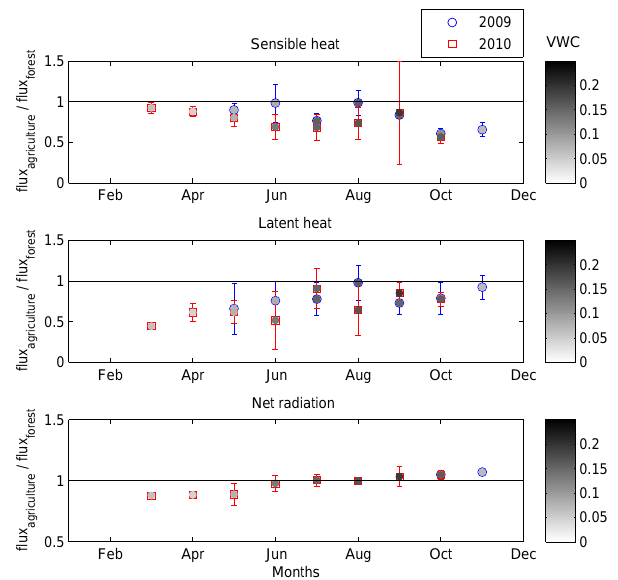
Figure 7. Examination of ratio of the daily fluxes by month and year. The ratios between flux measurements over the field and sa- vanna forest are shown according to the month ( x axis) and year (in color: blue indicates 2009 and red indicates 2010). The soil mois- ture value is shown with shading. Error bars show the standard de- viation around the average of daily ratios. Points below the 1 line indicate when the savanna-forest flux is higher than the agricultural field flux. It is important to note that the field was farmed in 2009 until the end of July but left fallow in